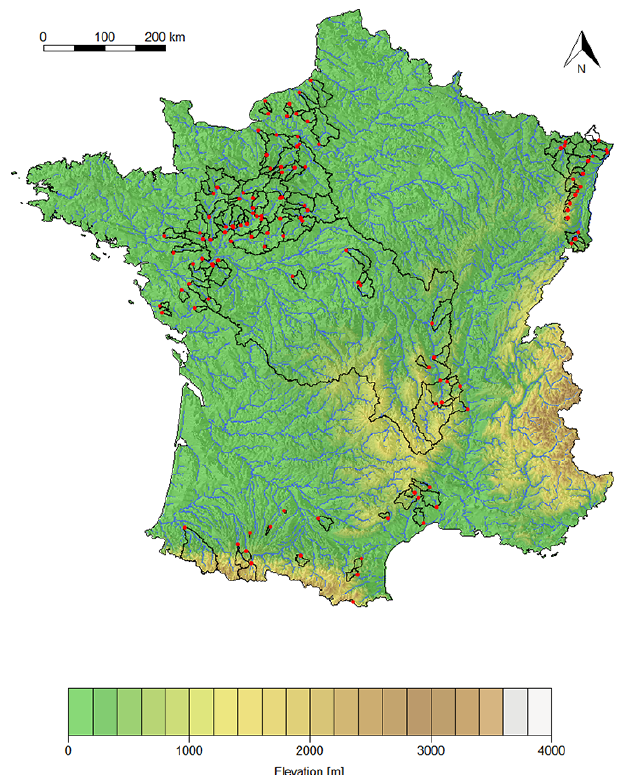
Figure 1. Location of the 118 catchments in France. Each outlet is shown by a red